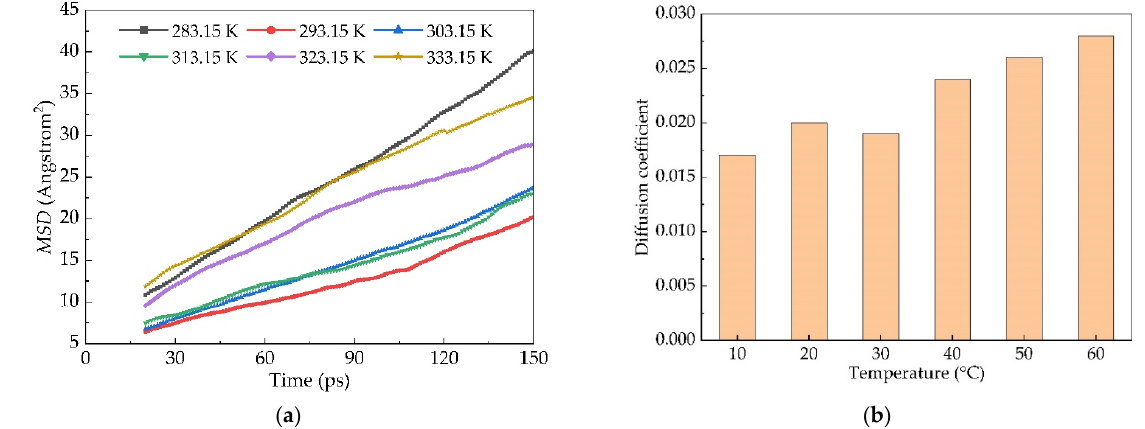
Figure 7. MSD and diffusion coefficient of Panjin 90# asphalt from new asphalt to old asphalt: ( a ) the dependence of MSD as a function of time and ( b ) the dependence of diffusion coefficient as a function of temperature.